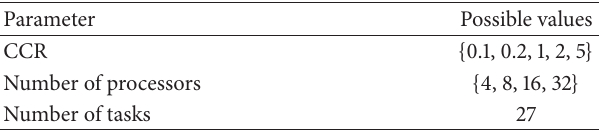
Table 4: Configuration parameters for the Gaussian elimination